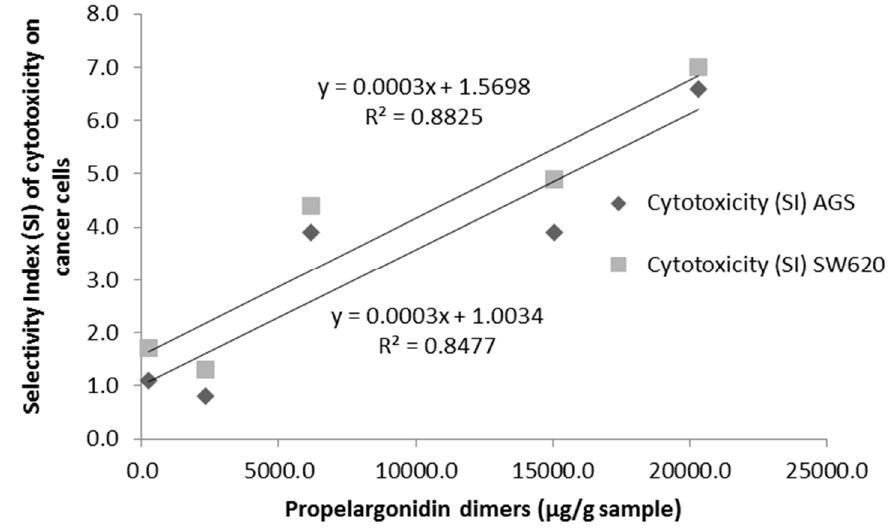
Figure 4. Correlation between propelargonidin dimers contents (UPLC/TQ-ESI-MS) and selectivity index (SI) of cytotoxicity on AGS and SW620 adenocarcinoma cell lines.